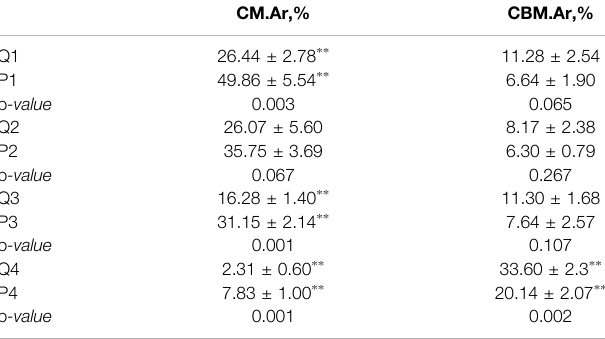
TABLE 1 | Comparisonoftibialmorphologicalparametersbetweenquailand